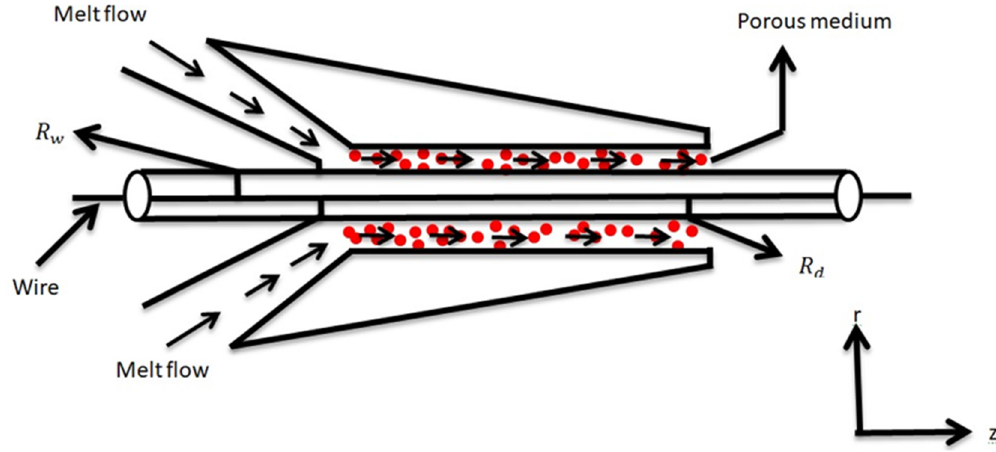
Figure 2. Geometry of the problem.